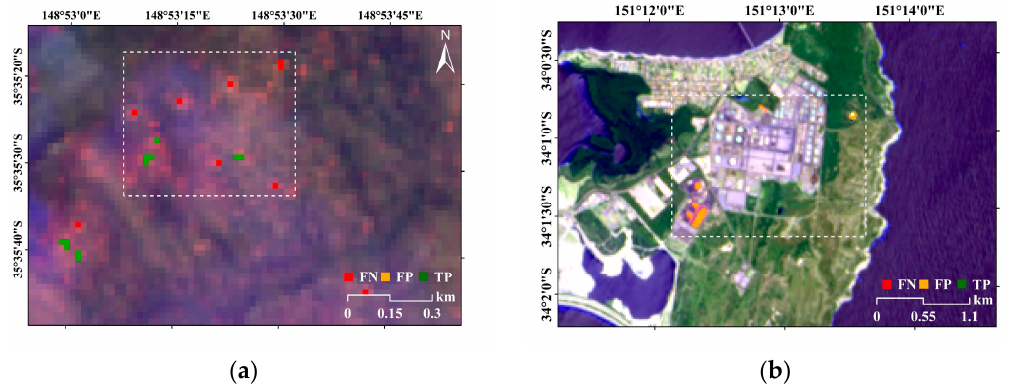
Figure 6. Examples of OEs and CEs in the active fire detection result: ( a ) OE; ( b ) CE.